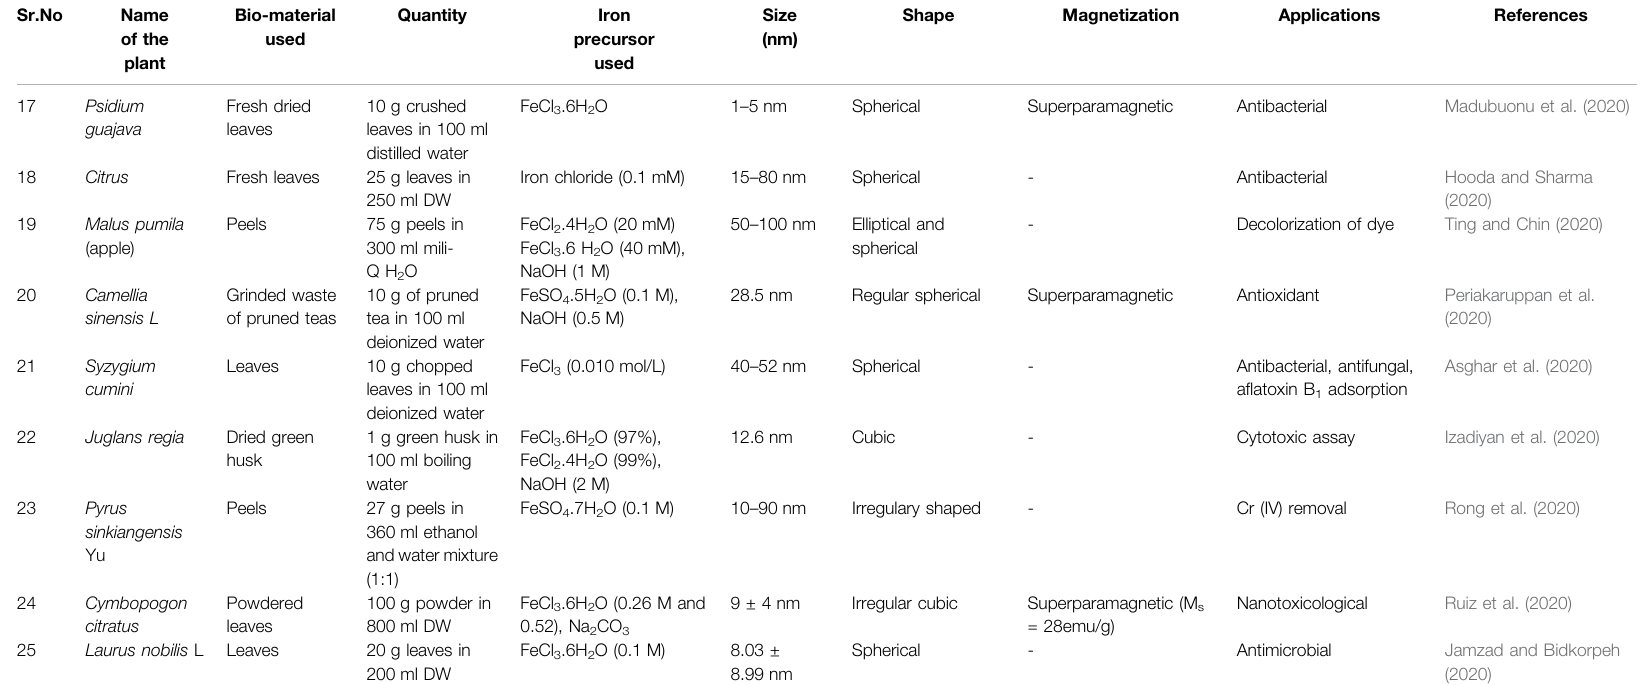
TABLE 1 | ( Continued ) Biosynthesis of Iron oxide nanoparticles by using